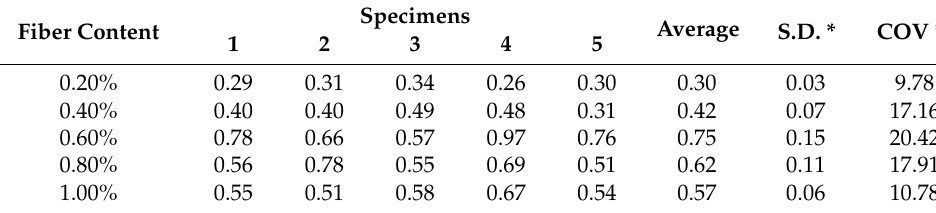
Table 4. Equivalent flexural strength (MPa).